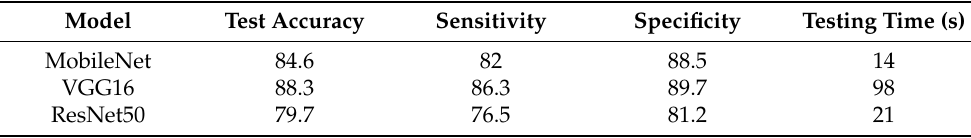
Table 7. Comparison of CNN image classification models.